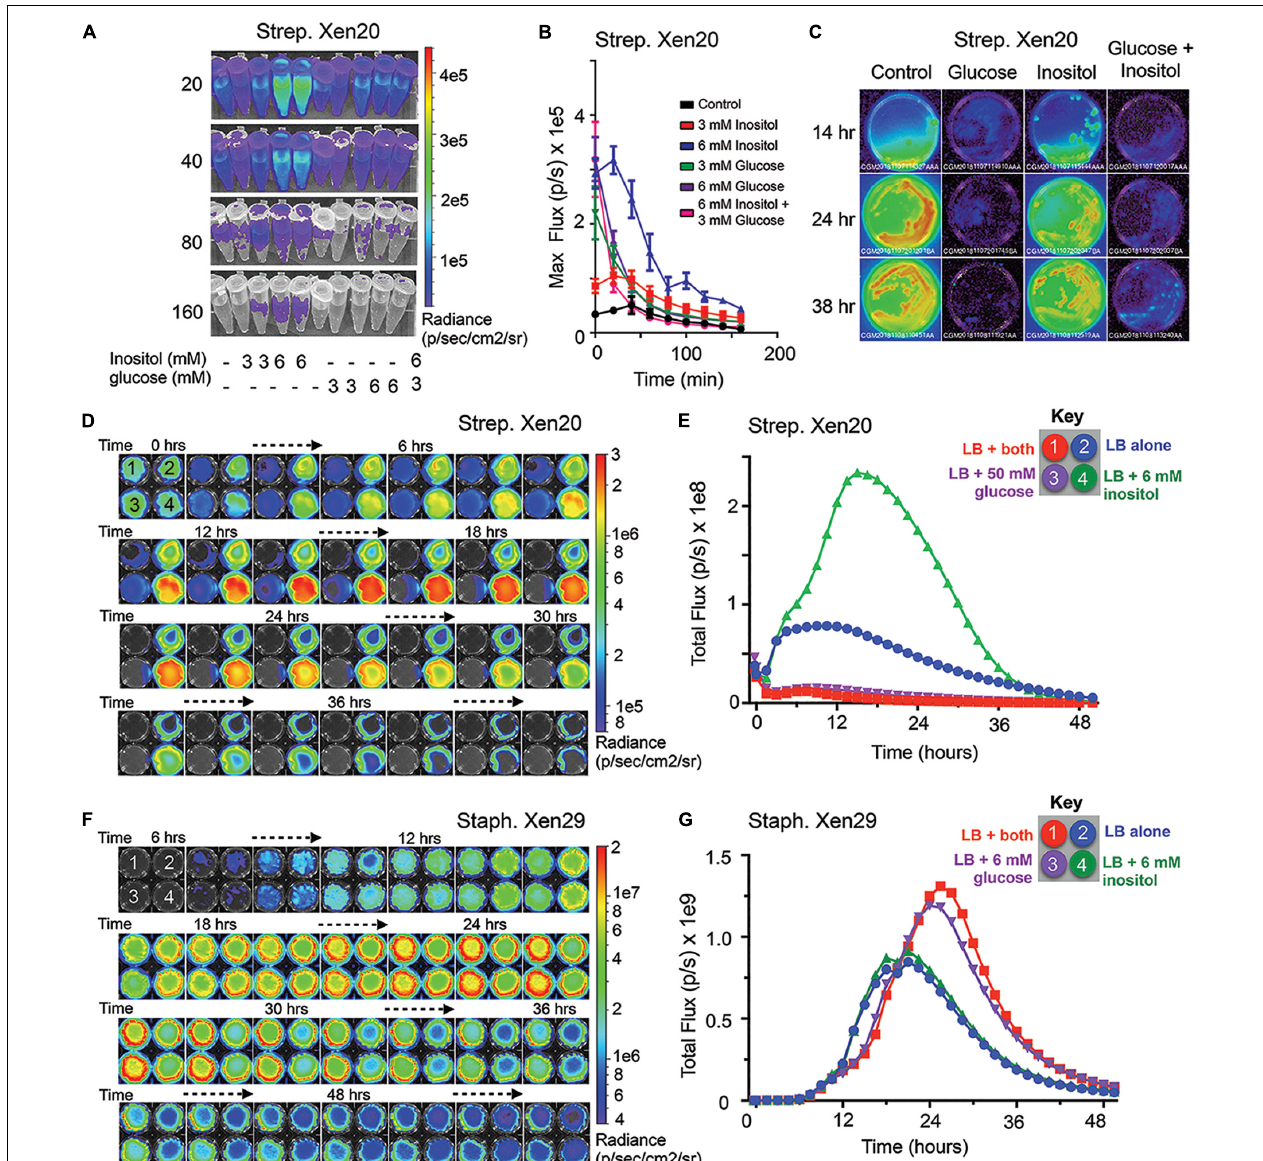
FIGURE 2 | Myo-inositol regulates luminescence of S. pyogenes Xen20. (A) Representative time course of Strep. Xen20 cells. Samples were grown to the stationary phase and then diluted in fresh phosphate-buffered saline (PBS) supplemented with one of either 3 or 6 mM myo-inositol or 3 or 6 mM D -glucose. (B) Quantification of luminescent signals from samples shown in panel (A) shown as the maximum rate of photons generated (max flux). (C) Bioluminescent imaging (BLI) of 65 mm Luria broth (LB) plates containing no additive (control), 50 mM glucose, 6 mM myo-inositol, or both taken at 14, 24, and 38 h after incubating at 37 ◦ C. (D) Strep. Xen20 growth on 6-well, flat-bottomed culture plates coated with LB agar containing either both myo-inositol and glucose (1, indicated in red), no additive (2, blue), 50mM glucose (3, purple), or 6 mM myo-Inositol (4, green) and imaged over 48 h in the IVIS. (E) BLI quantification of the plates from panel (D) as the total rate of photons generates (Total flux). (F) Staph . Xen29 incubated on 6-well, flat-bottomed culture plates coated with LB agar containing either no additive (control), 6 mM glucose, 6 mM myo-Inositol, or both and imaged over 60 h in the IVIS. (G) BLI quantification of the plates from panel (D) as the total rate of photons generates (Total